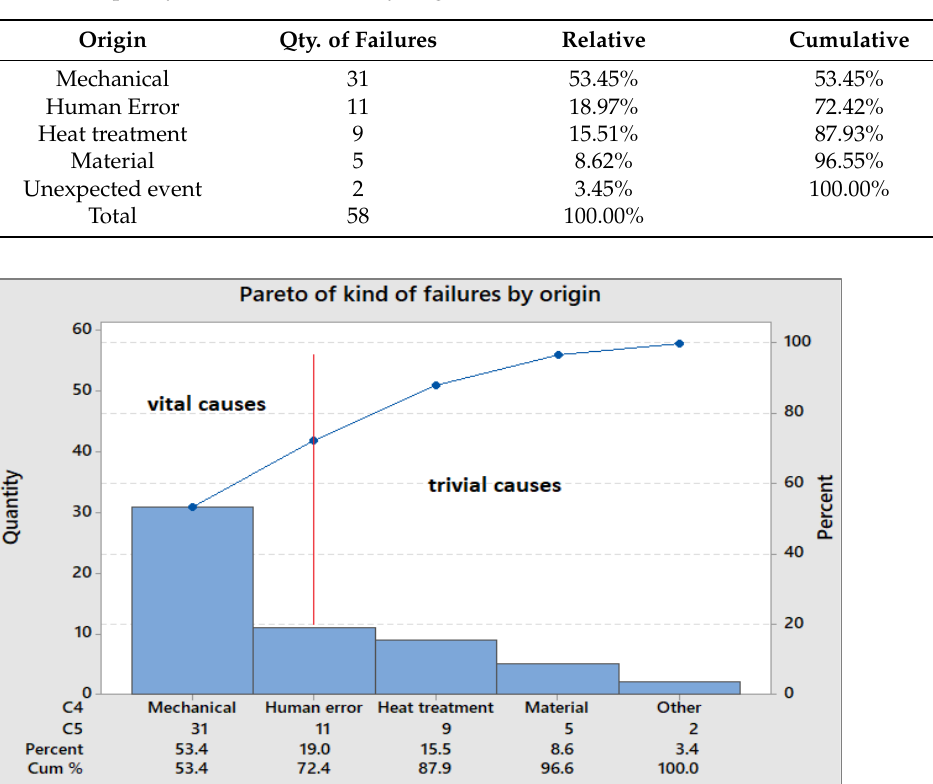
Table 7. Component–subsystem relationships presented in the failure analysis and their parameters from 25 to 30 January, 2021.